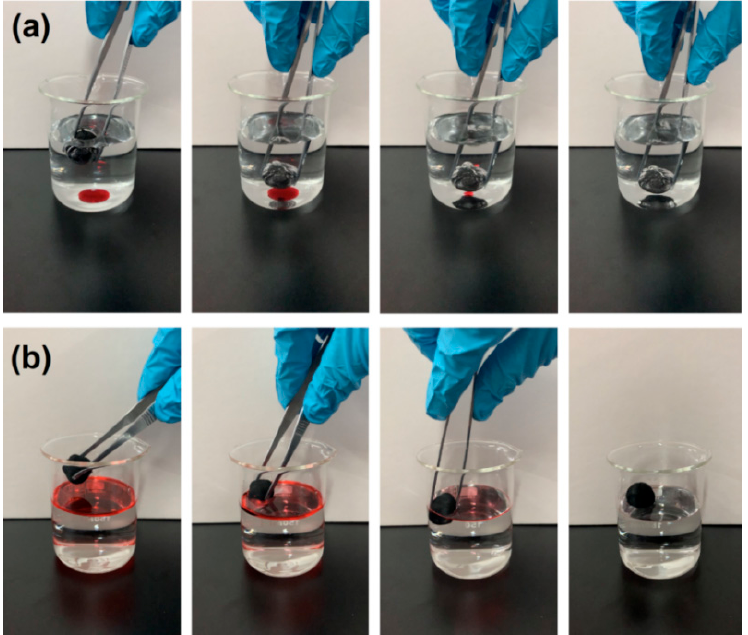
Figure 8. ( a ) Sorption process of dichloromethane (dyed with Oil Red O) by C ZIF-8/CNTs/CCBs. ( b ) Sorption process of n-hexane (dyed with Oil Red O) by C ZIF-8/CNTs/CCBs.